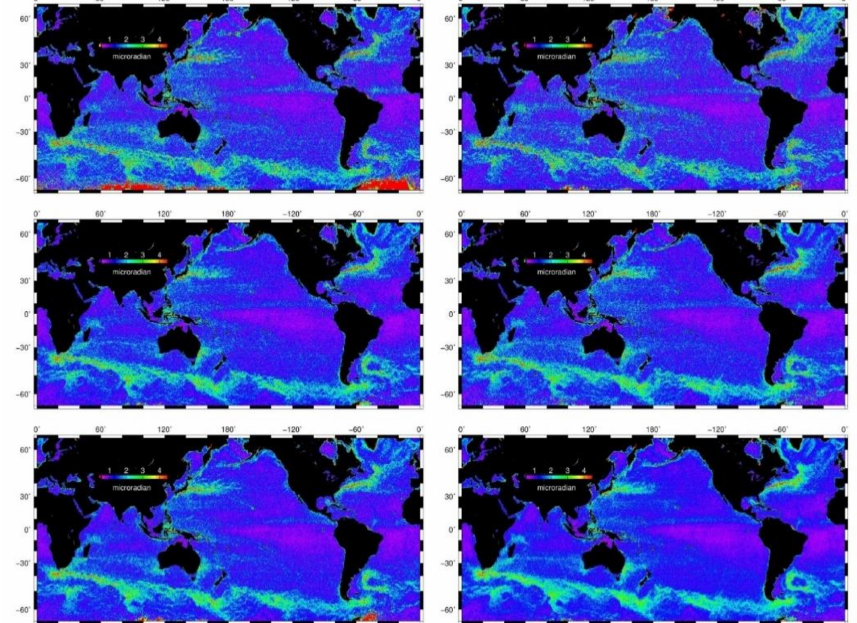
Figure 3. Median absolute of along-track sea surface slope differences with respect to the SSV28.1 vertical deflection model derived from a multi-satellite altimeter dataset [5]. Upper left: J1 sub-cycle 1. Upper right: Jason 1 sub-cycle 2. Center left: J2 LRO Cycle 1. Center right: Jason 2 LRO cycle 2. Lower left: J1 Entire LRO. Lower right: Jason 2 Entire GM (Both LRO cycles).